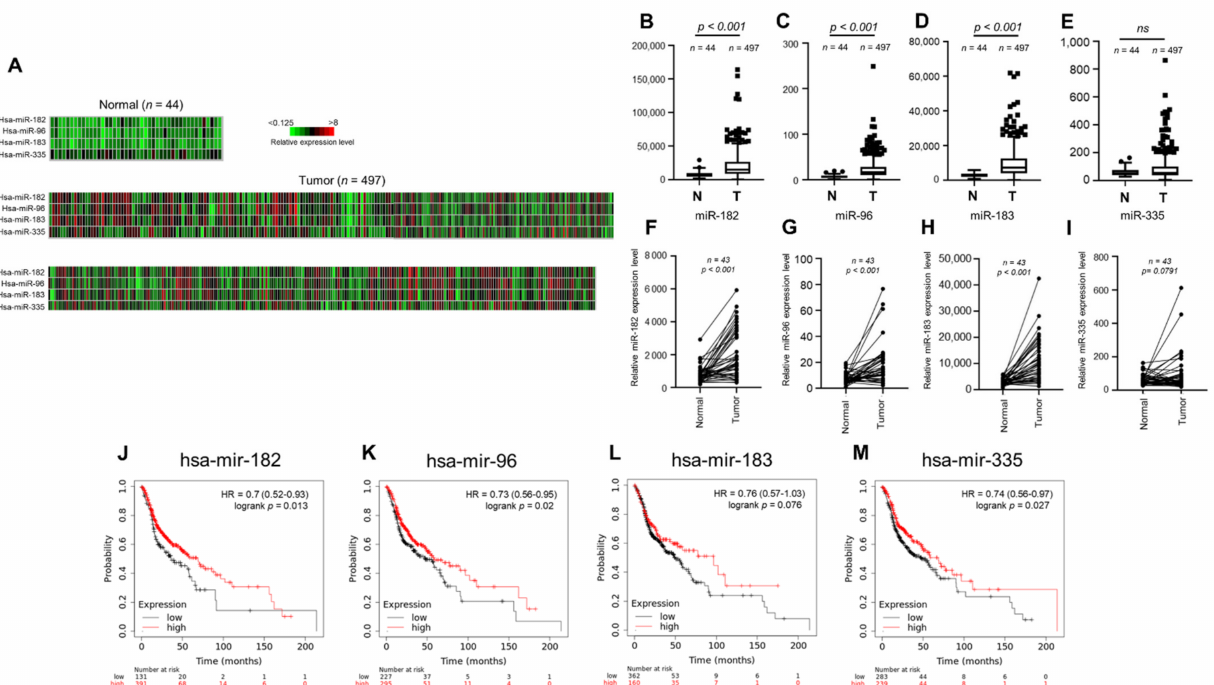
Figure 1. Expression of the miR-182/96/183 cluster in HNSCC patients and survival analysis of patients stratified by miR-182/96/183 cluster expression. ( A ) Heatmaps of miR-182, miR-96, miR-183 and miR-335 expression in normal tissues and HNSCC tissues in the TCGA microRNA sequencing database (TCGA-HNSC). ( B – E ) Comparison of miR-182, miR-96, miR-183 and miR-335 expression in the TCGA-HNSC tumor and normal tissues. ( F – I ) The expression of miR-182, miR-96, miR-183, and miR-335 in 43 tumor tissues paired with corresponding adjacent normal tissues in the TCGA-HNSC dataset. ( J – M ) Comparison of overall survival in patients with high or low expressions of miR-182, miR-96, miR-183 and